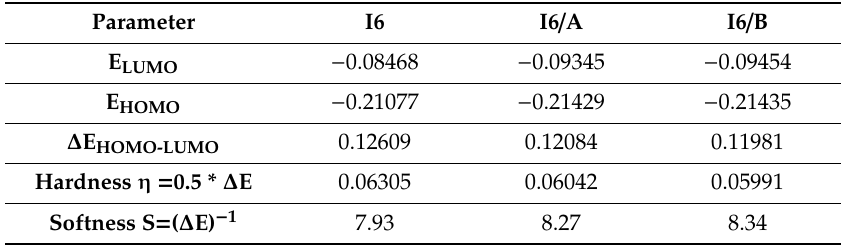
Table 3. Frontier molecular orbitals (FMOs) energies (a.u.), polarizability, α (Bohr 3 ), and dipole moment µ (Debye) of the I6 base, as well as the I6 / A and I6 / B SMHBCs.